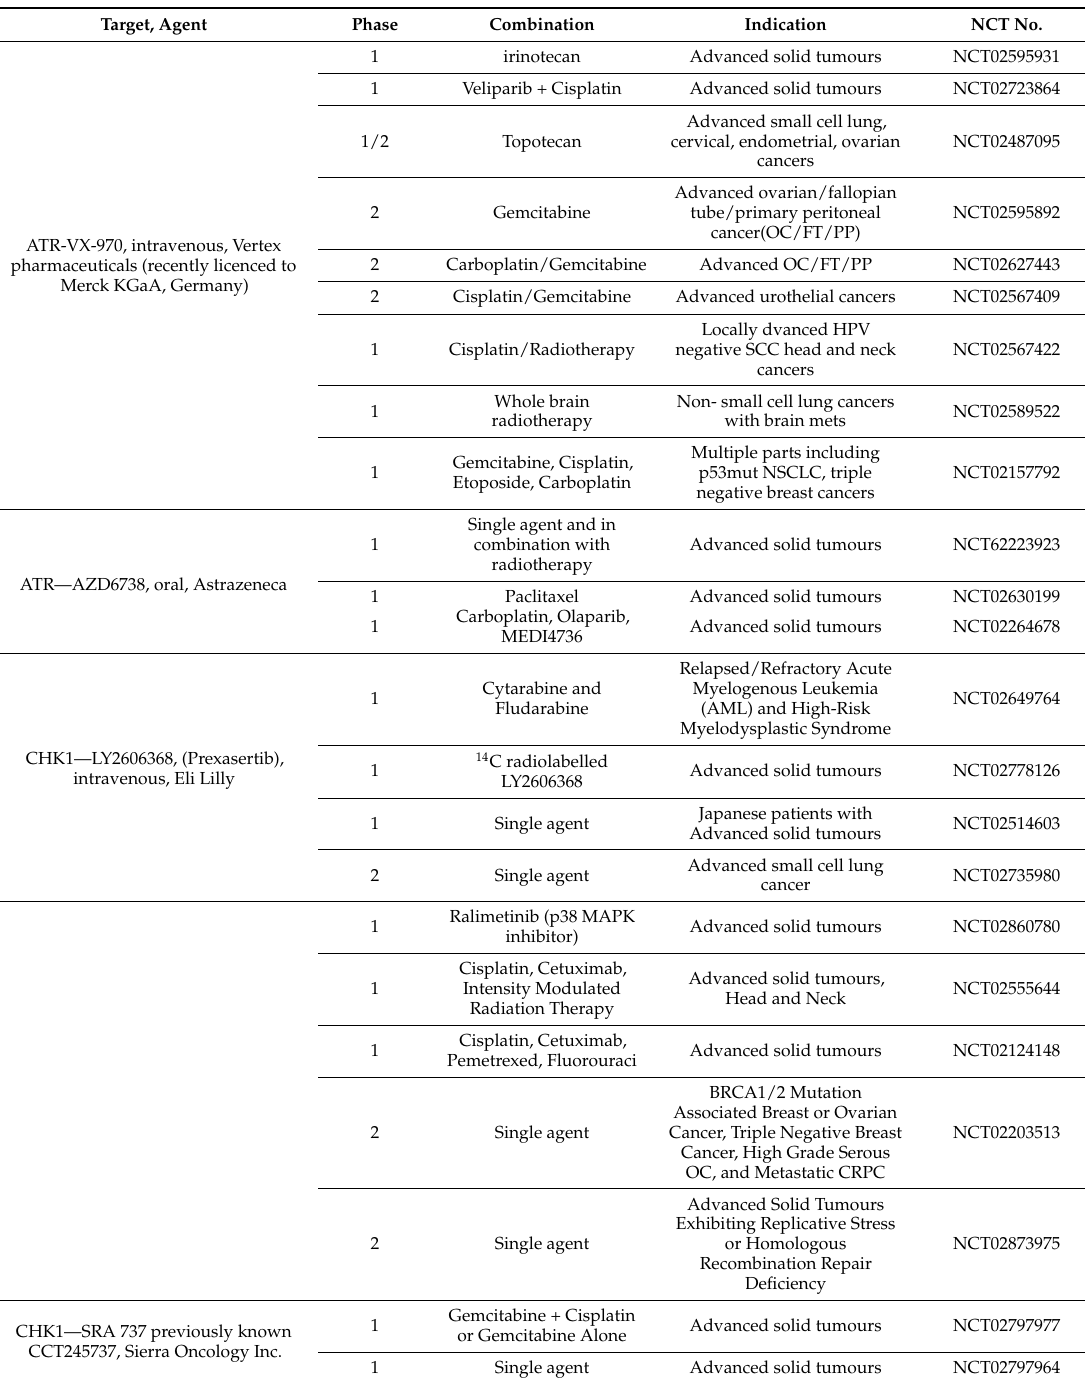
Table 2. Open and actively recruiting trials using ATR and CHK1 inhibitors (February